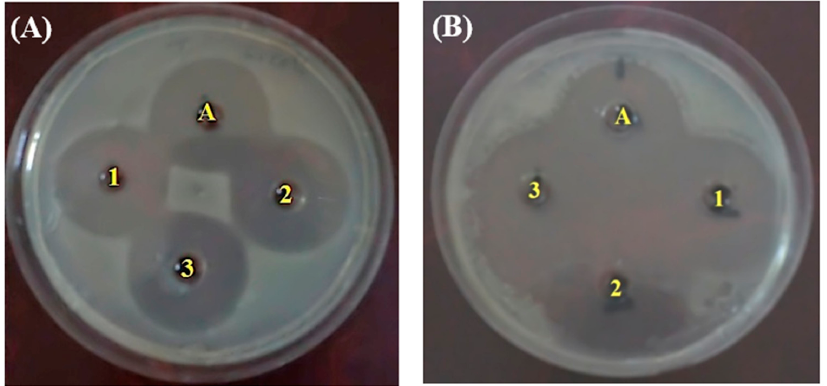
Figure 11. The antibacterial activity of TiO 2 NPs with ( A ) amoxicillin against E. coli , and ( B ) S. aureus .